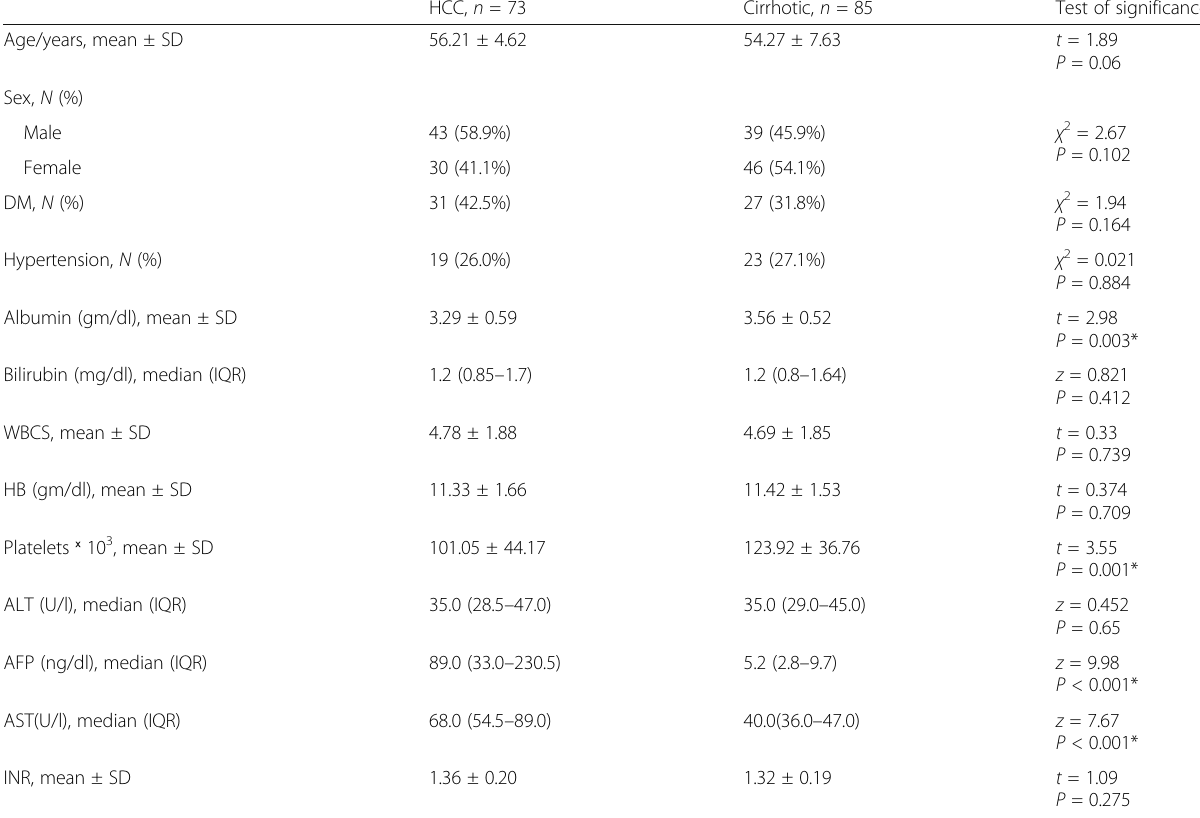
Table 2 Sociodemographic characteristics of the studied groups HCC, n = 73 Cirrhotic, n =